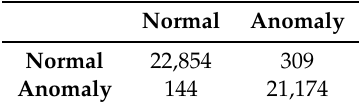
Table 31. Confusion matrix for Adaboost Reptree.